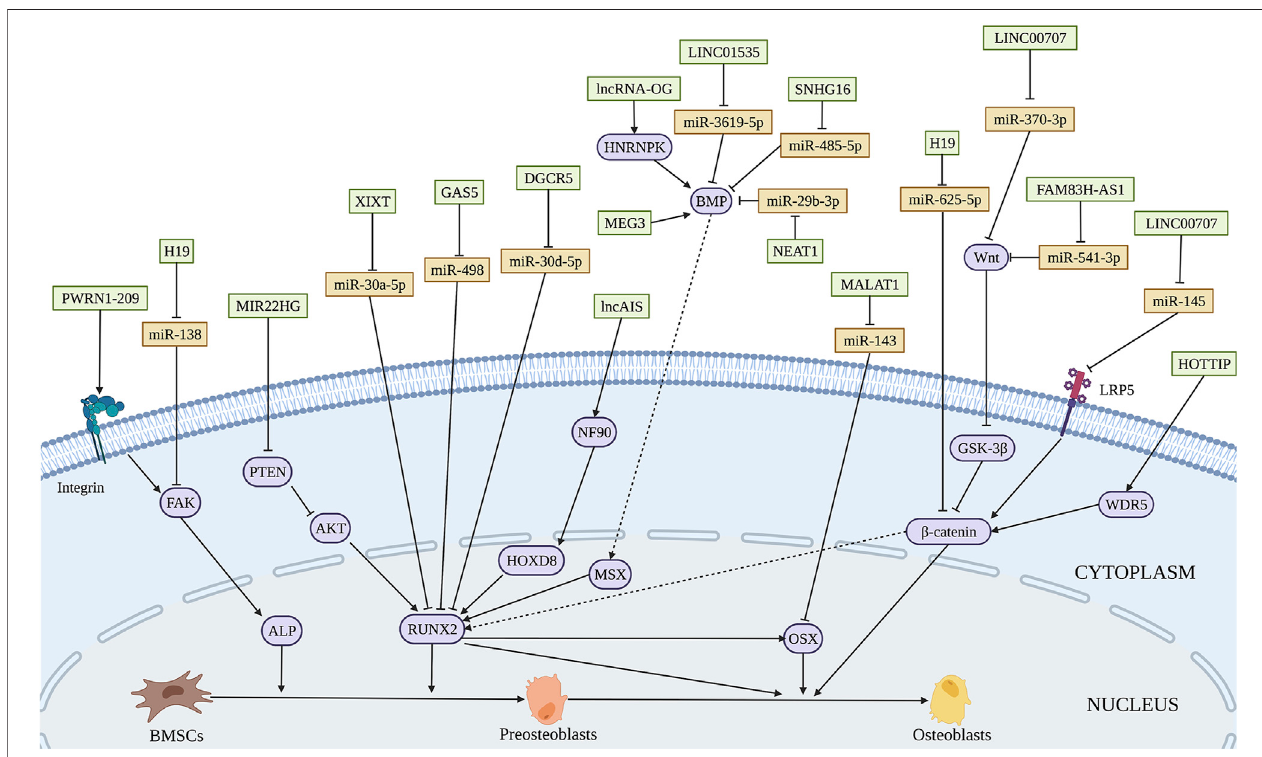
FIGURE 4 | Illustration of the role and regulatory mechanism of lncRNAs-induced osteogenic differentiation of BMSCs. Various lncRNAs promote BMSCs osteogenesis through sponging miRNA (orange), activating epigenetic regulation, and mediating other regulatory mechanisms. (Created with BioRender.com).